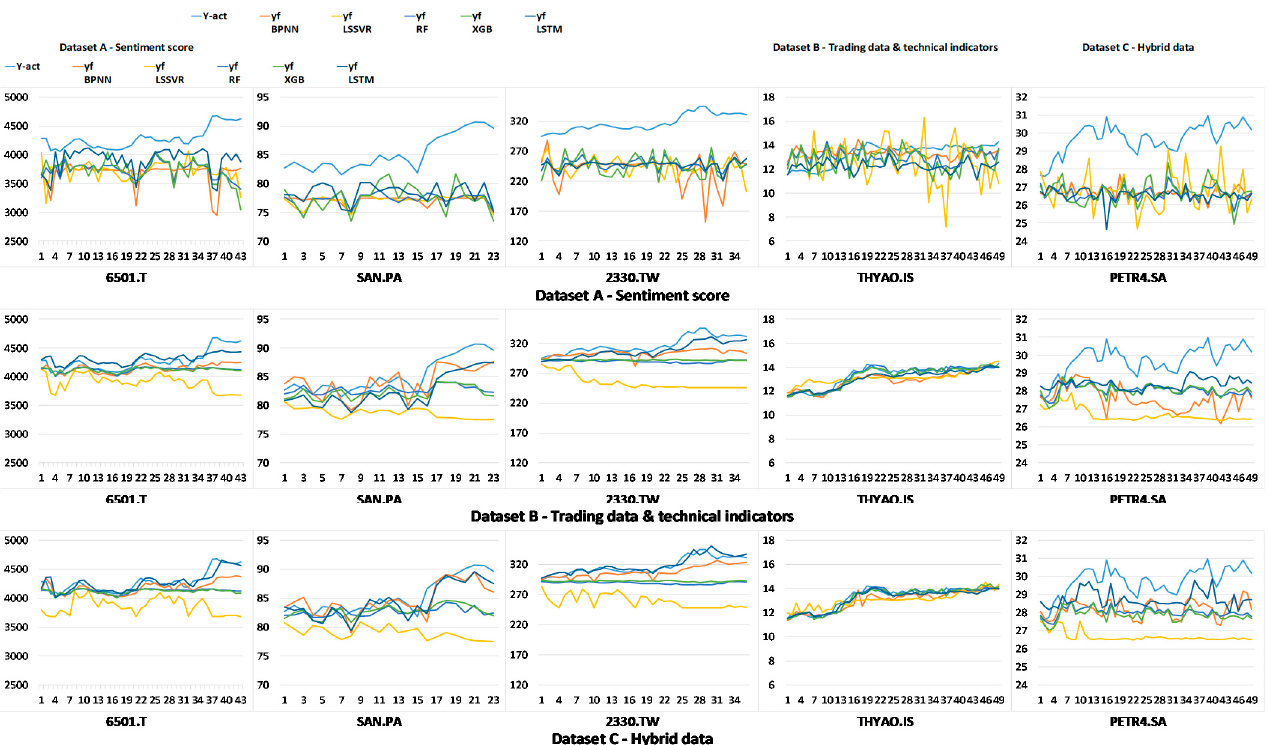
Figure 11. Point-to-point plots of actual values and predicted values of corporations’ stock prices.